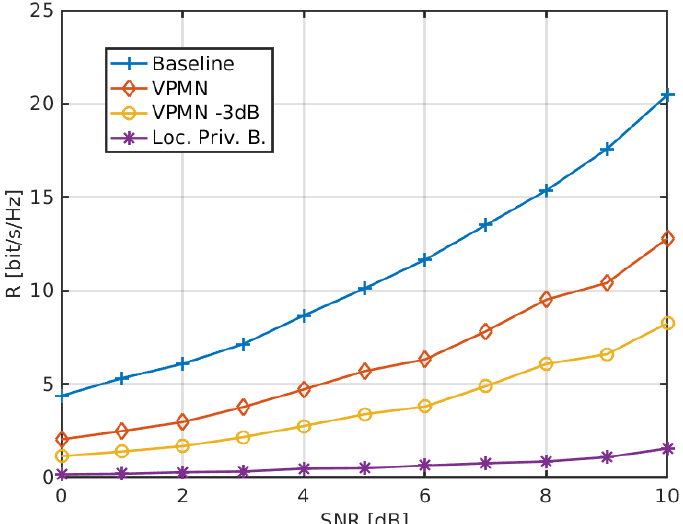
Figure 7. Average achievable rate obtained by the baseline system (no privacy constraints), by the VPMN (with/without 3dB attenuation), and by the location-privacy beamforming of [27], as a function of the average SNR. UEs are equipped with N t = 4 antennas, UE-A is located at position (0,0), the gNB (with 65 antennas) at (4,0), and UE-B at position